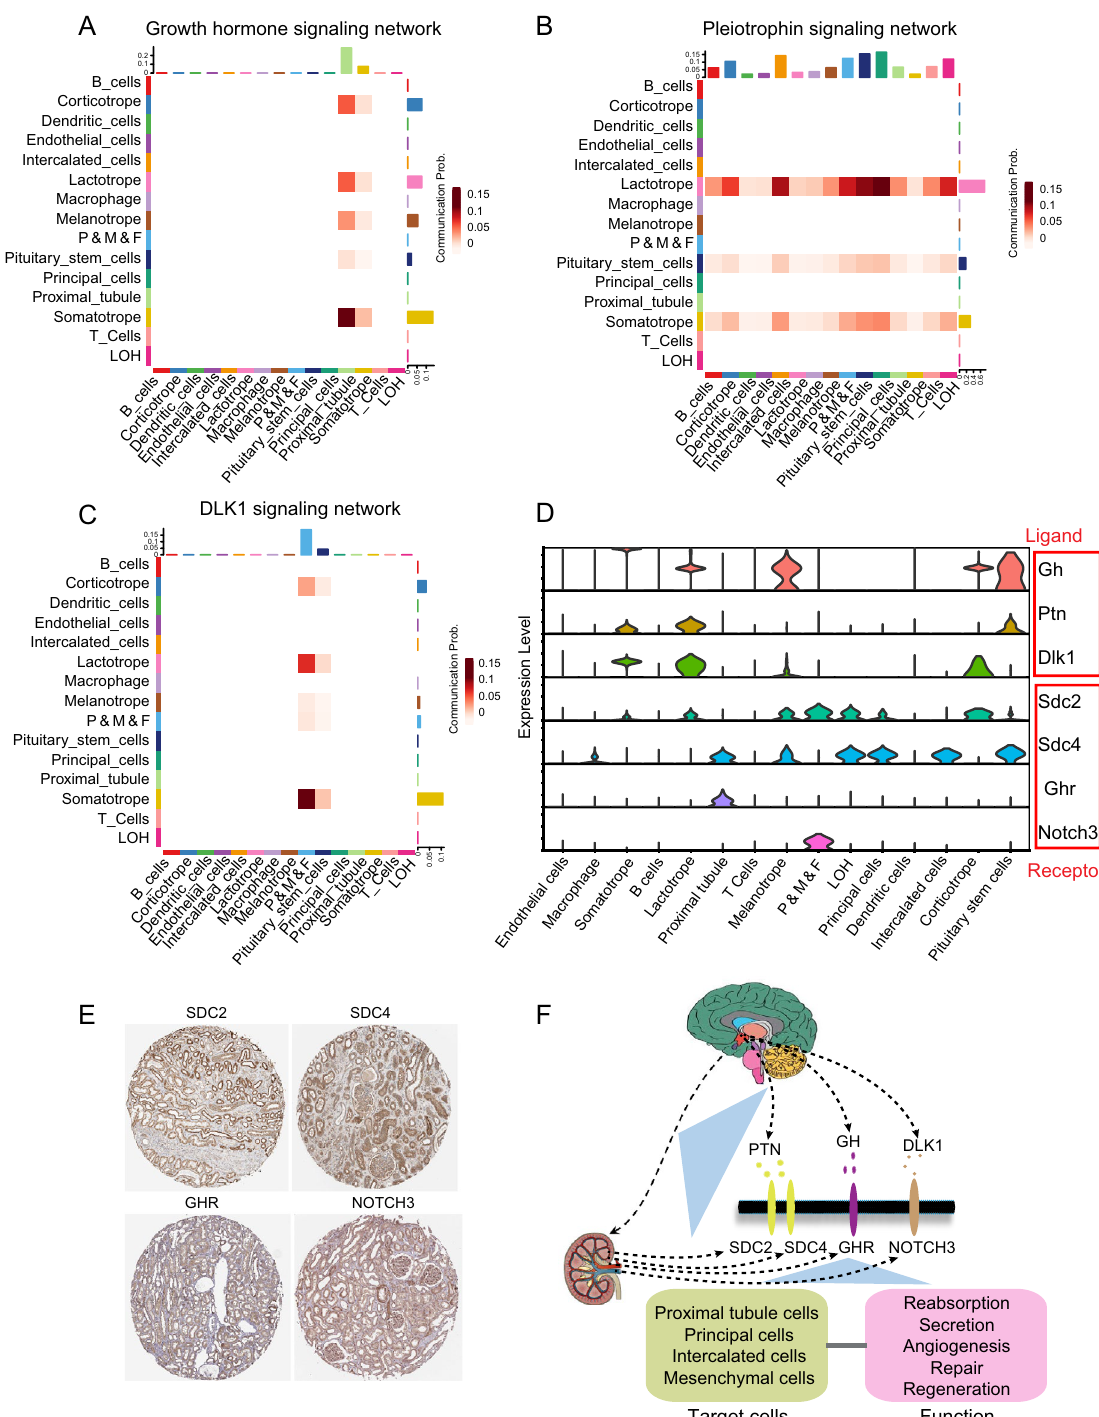
Figure 4. GH, PTN, and DLK1 signaling network among all cell types. ( A ) Communication probability of the GH ligand–receptor pair was calculated for cell–cell communication, with the color range representing the communication probability. ( B ) Communication probability of the PTN ligand–receptor pair was calculated for cell–cell communication, with the color range representing the communication probability. ( C ) Communication probability of the DLK1 ligand–receptor pair was calculated for cell–cell communication, with the color range representing the communication probability. ( D ) Expression of most contribution ligand–receptor pairs among the cell types. ( E ) Immunohistochemical staining of GHR, SDC2, SDC4, and NOTCH3 in the human kidney. ( F ) Hypothesis of the pituitary–kidney